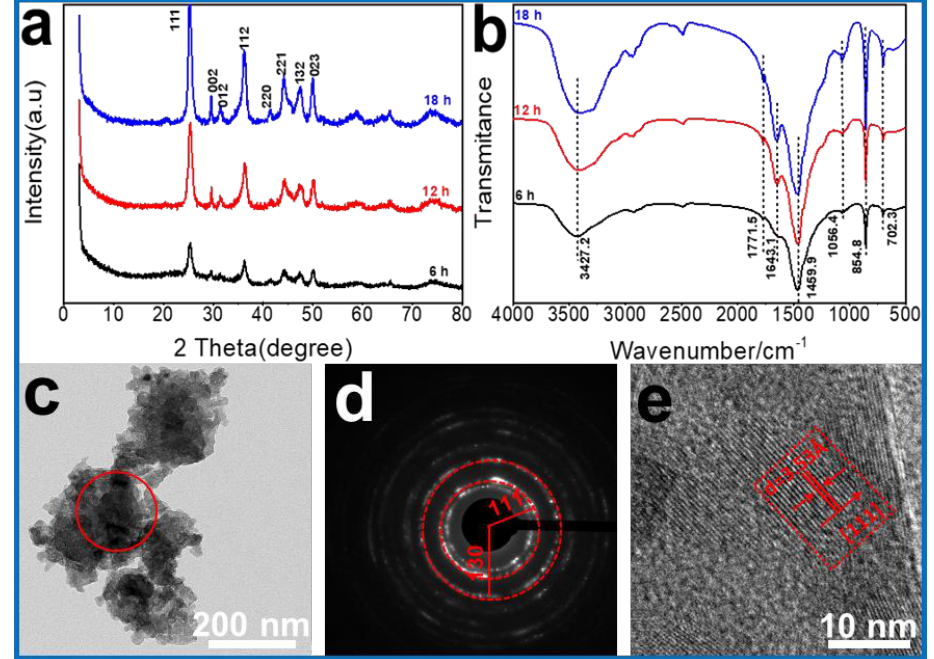
Figure 4. ( a ) XRD patterns and ( b ) FT-IR spectrum of SrCO 3 obtained over a range of times with a nano-MMT concentration of 2 mL/L, ( c ) TEM image of a SrCO 3 , ( d ) selected area electron diffraction (SAED) pattern shows that this block is polycrystalline SrCO 3 ; ( e ) high-resolution transmission electron microscopy (HRTEM) image of the SrCO 3 showing continuous (111) lattice fringes.